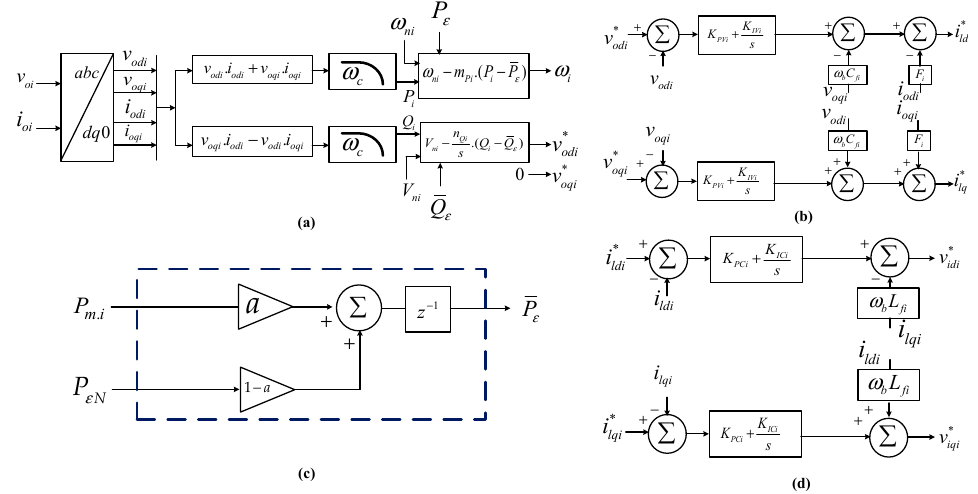
Figure 3. ( a ) Distributed averaging at every node ( b ) Steady state results of quasi-averaging estimates for four node system ( c ) Time simulation of quasi-averaging estimates for four node system showing individual samples.